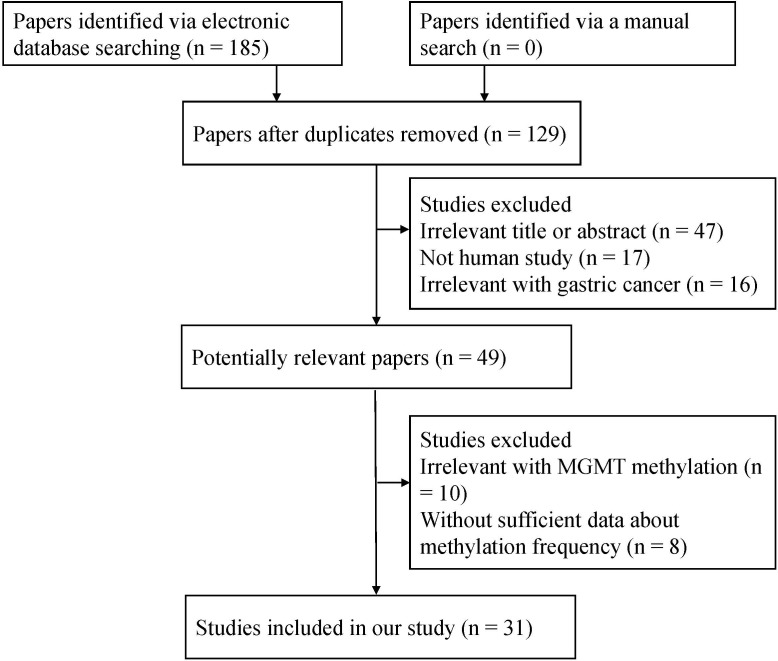
Flow chart of the literature search strategy.